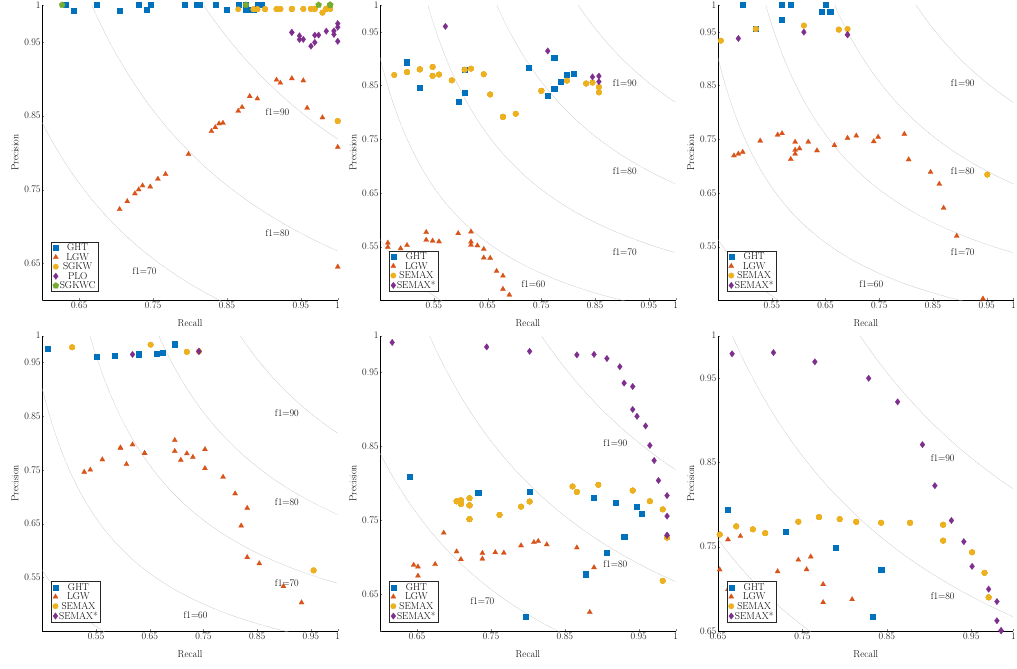
Figure 4. Precision-recall values for evaluated ITD